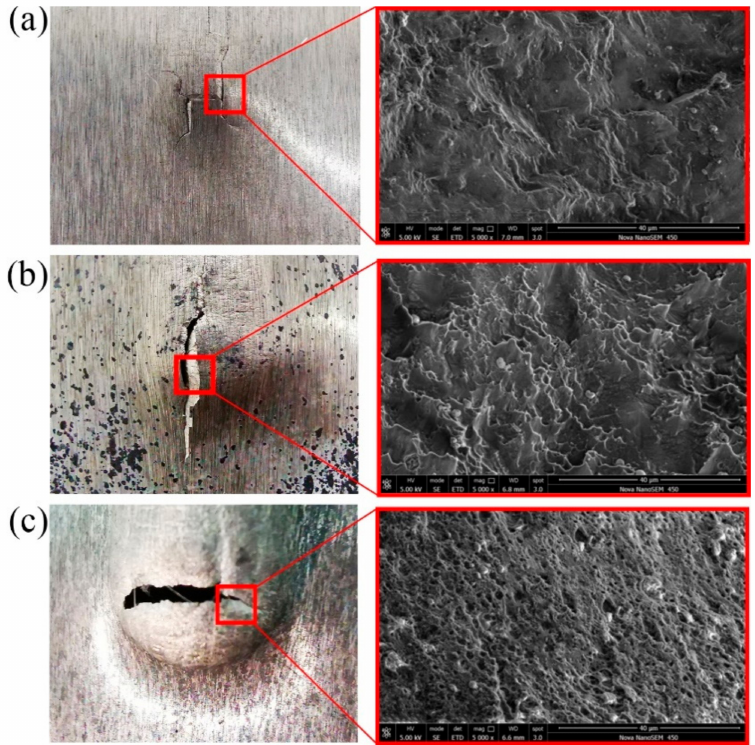
Figure 11. Comparison of SEM fracture graphs: ( a ) 20 ◦ C, ( b ) 150 ◦ C and ( c ) 250 ◦ C.